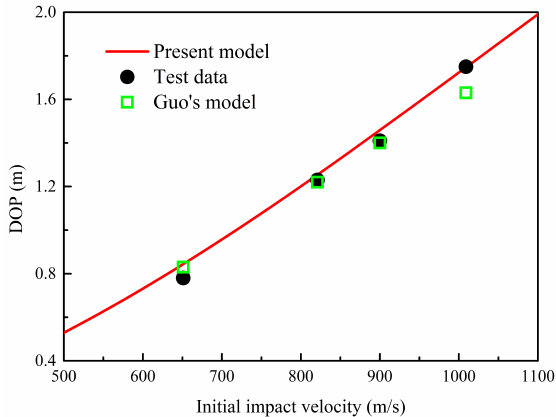
Figure 11. Relationship between impact velocity and DOP. The proposed model agreed well with the experimental data, especially under the condition of high-speed